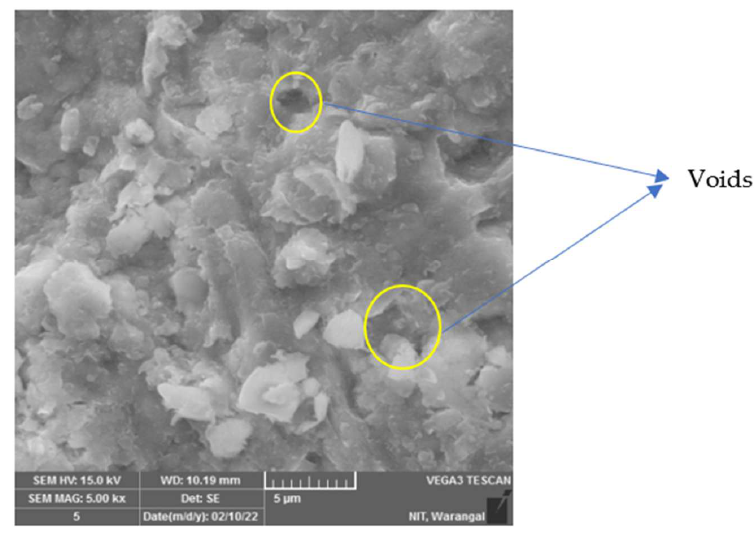
Figure 1. SEM image of clay. Table 2. Basic Characteristics and Chemical Composition of GS.